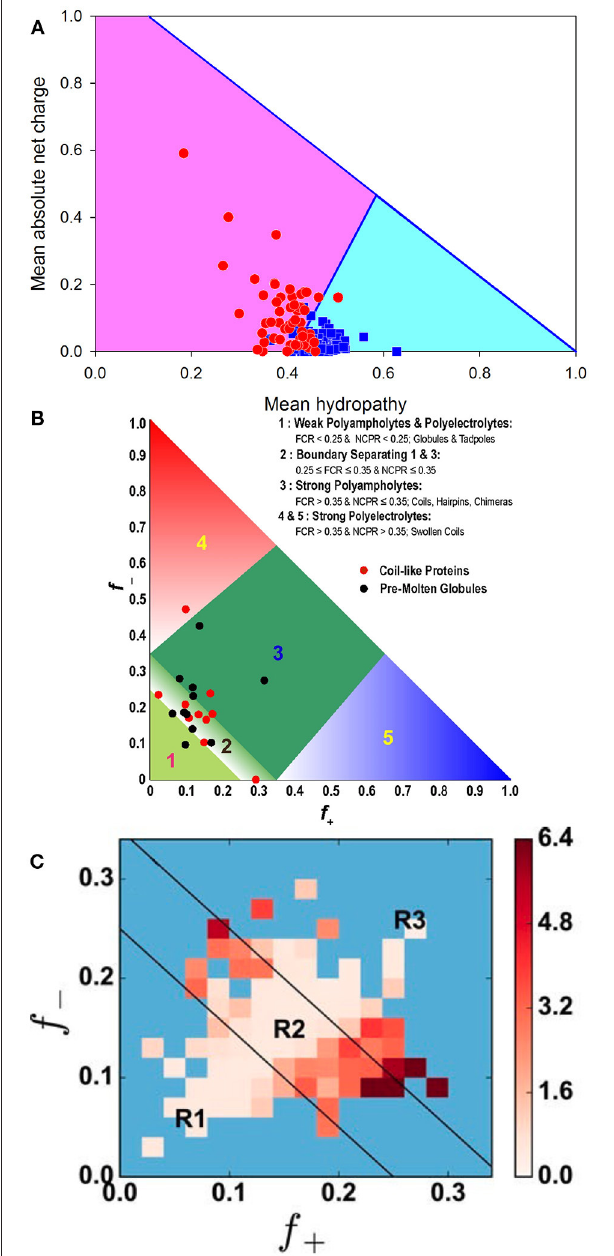
FIGURE 3 | Illustrating roles of charges in conformational control of IDPs. (A) Evaluation of the charge-hydropathy space available for compact proteins (blue squares) and extended IDPs (red circles). The area accessible to sequences encoding compact proteins is shown as a light cyan triangle, whereas the area accessible to sequences encoding IDPs is depicted as light pink pentagon. These two areas are defined by two boundaries, the known boundary separating compact proteins and extended IDPs ( < R > = 2.785 < H > -1.151, where < R > and < H > correspond to the absolute mean chare and mean hydropathy, respectively [40]), and the boundary showing logical limits of the CH-space ( < R > = 1.125–1.125 < H > ). Reprinted from Uversky [35]. (B) Diagram-of-states for IDPs based on the peculiarities of the distribution of charged residues within the amino acid sequences. Region 1